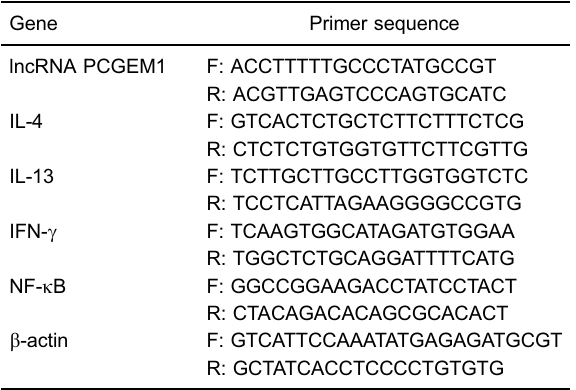
Table 1. Primer sequences for